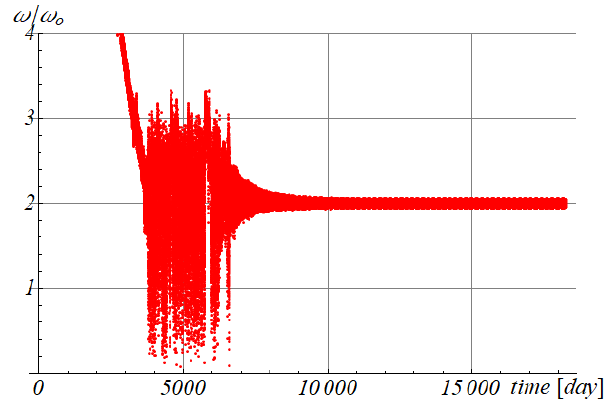
Figure 16. Angular velocity to orbital angular velocity ratio ω / ω 0 in case of magnetic rotation final regime.